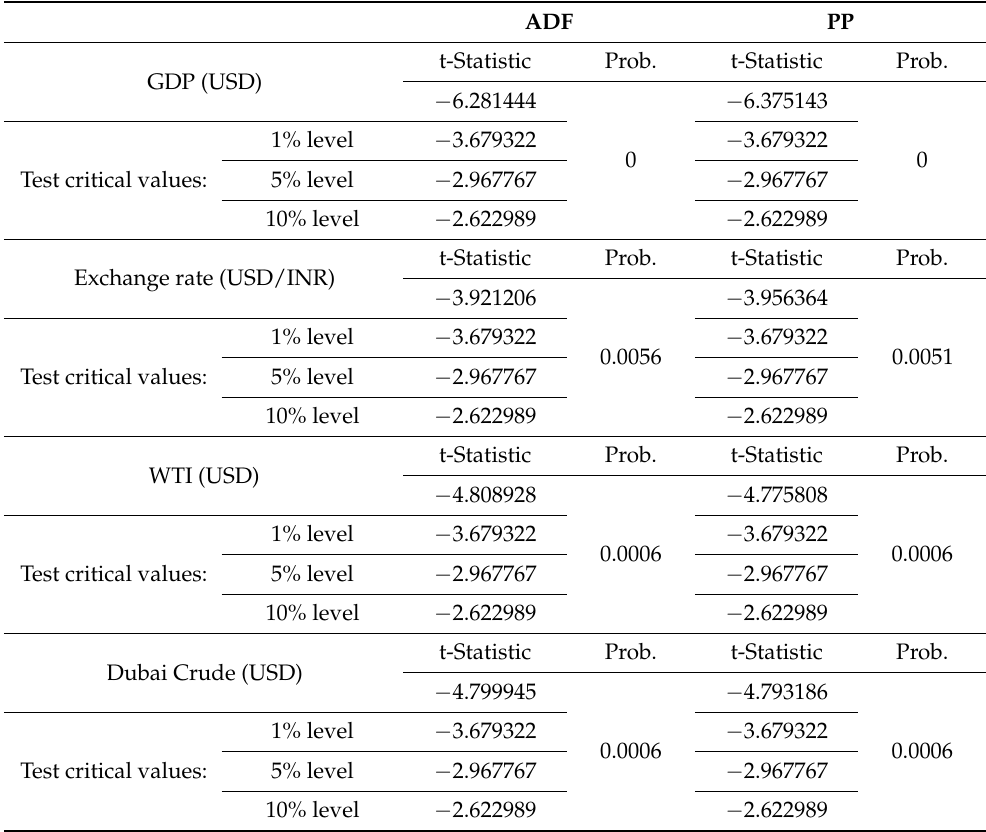
Table 3. The Results of Unit Root Test for Crude Oil Price on GDP and Exchange Rate in India during the period from 1990 to